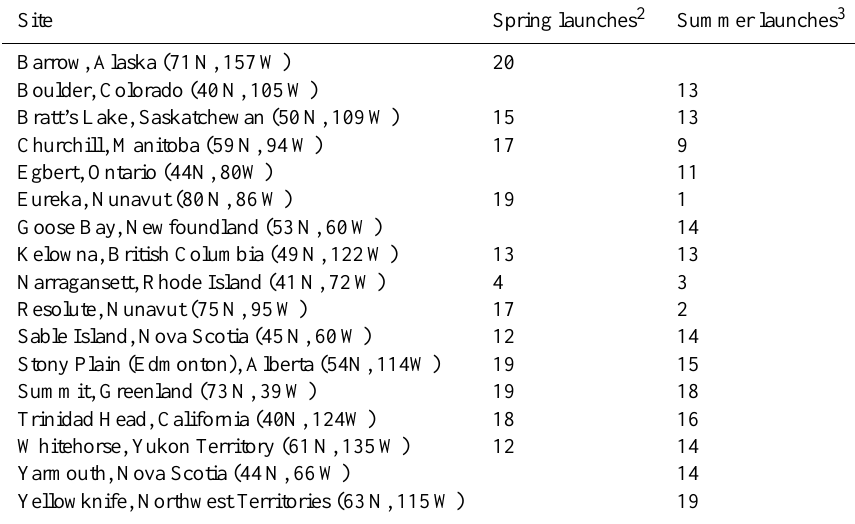
Table 3d. ARC-IONS 1 ozonesonde sites during ARCTAS Site Spring launches 2